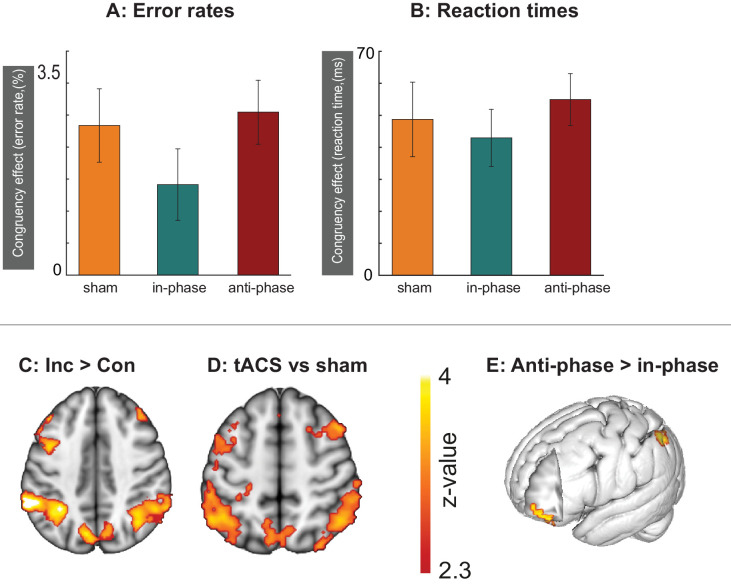
Behavioral and neural effects in different task conditions.(A) Average congruency-effects in percentage correct over all three conditions. Differences between in-phase and anti-phase were trend-significant (p=0.06) when not controlling for dose dependence. (B) Average reaction time congruency effects, visual inspection shows similar patterns as the error-rates but there are no statistical differences between conditions. Reaction time effects were not anticipated based on earlier brain-stimulation studies using this task (Volman et al., 2011a). (C) Increased activity in posterior parietal and premotor areas for incongruent versus congruent and (D) stimulation versus sham. (E) Contrasting in-phase with the anti-phase condition shows increased activity in the left aPFC and PPC, contralateral to the prefrontal stimulation site. Speculatively, these effects might suggest network compensatory effects when right aPFC is desynchronized from the control network.